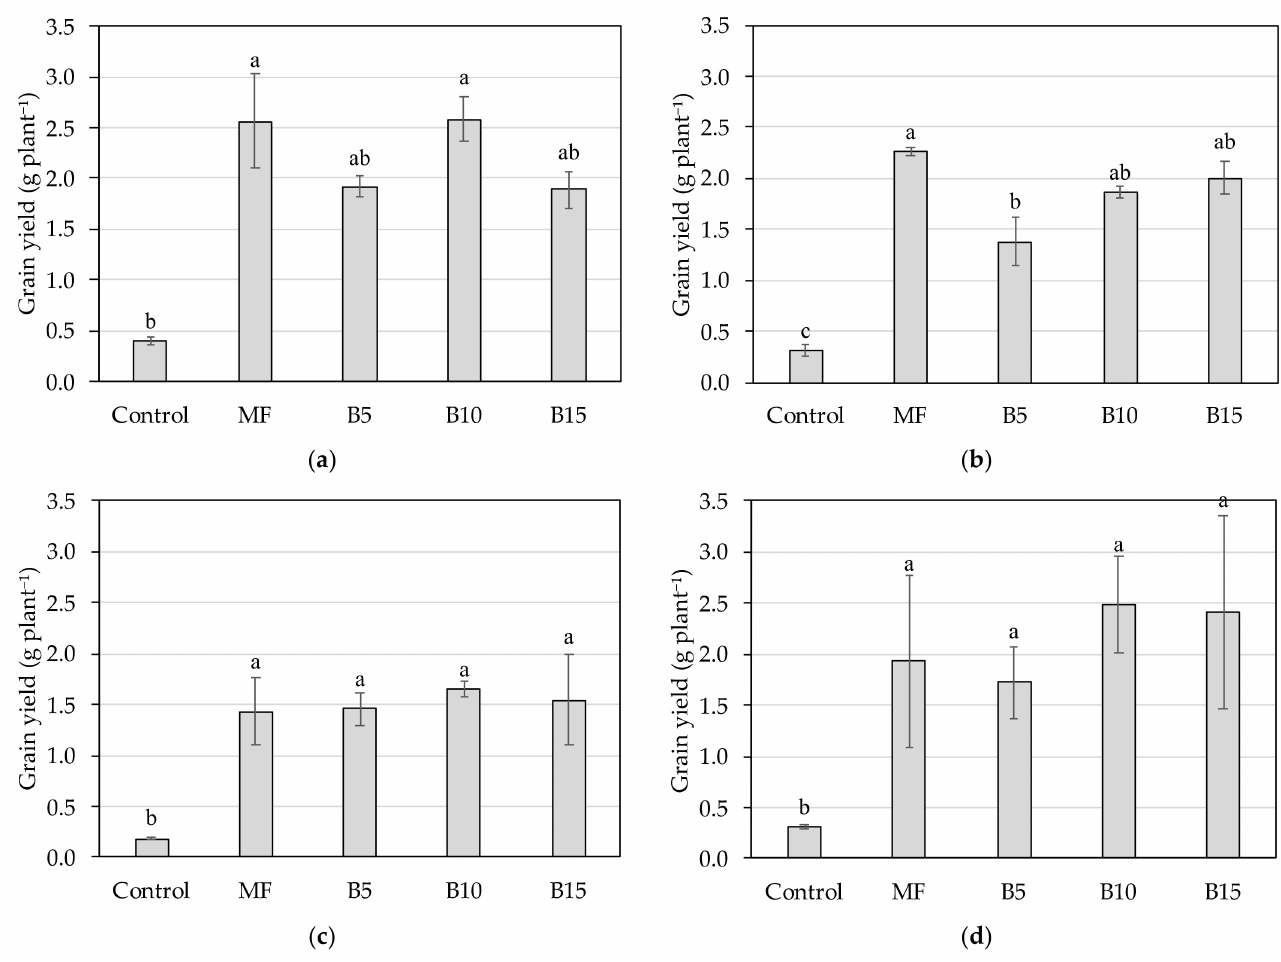
Figure 5. Grain yield (DW g plant − 1 ) of winter cereals, as affected by fertilizer treatments: ( a ) barley; ( b ) common wheat; ( c ) durum wheat; and ( d ) oat. Bars with different letters are significantly different according to Tukey’s test ( p > 0.95). Error bars represent standard